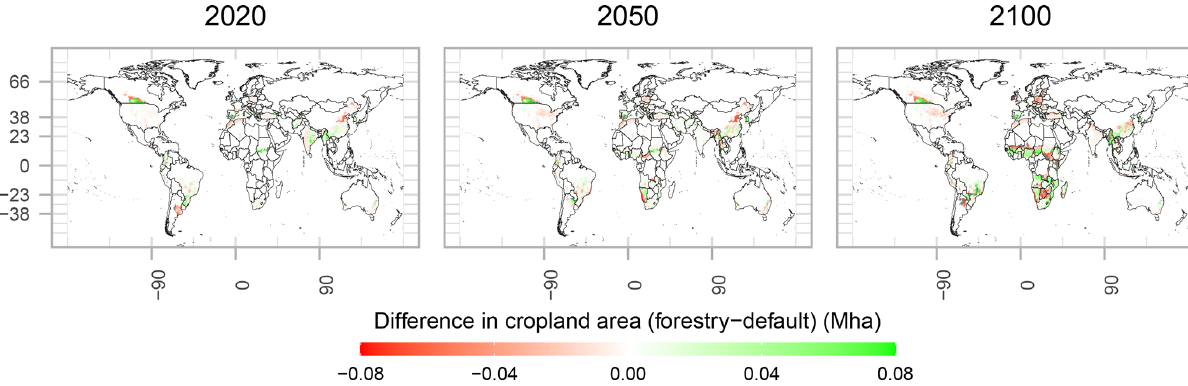
Figure 13. Difference in cellular cropland area between the forestry scenario and the default scenario (in Mha) in 2020, 2050 and 2100. Shades of red indicate cropland loss and shades of green indicate cropland increase when timber production is accounted for in